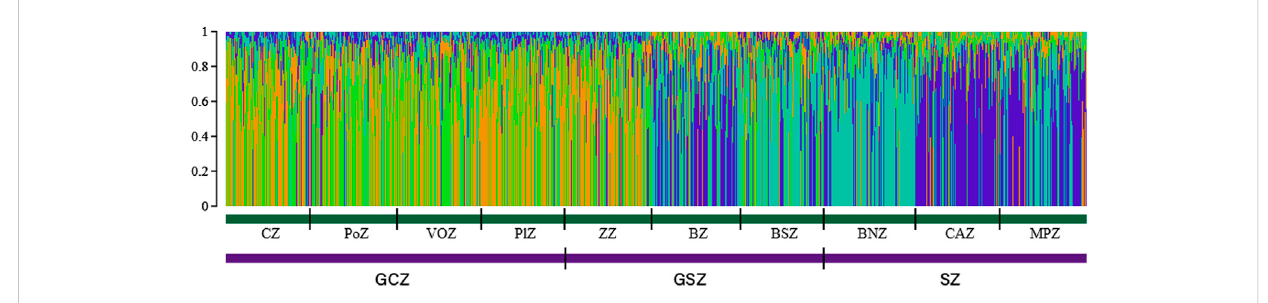
FIGURE 4 Goat population structure determined by STRUCTURE 2.3. Estimated histogram of the population structure with two ancestral populations ( K = 4). Each vertical bar represents one individual in the population based on the percentage of group membership, into the 4 inferred subgroups.